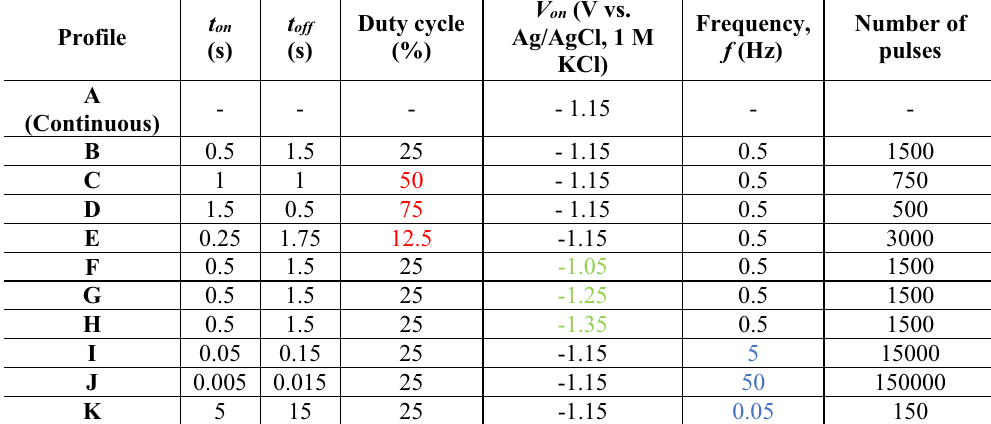
Table 1. Employed parameters for ZnO electrodeposition on LIG.